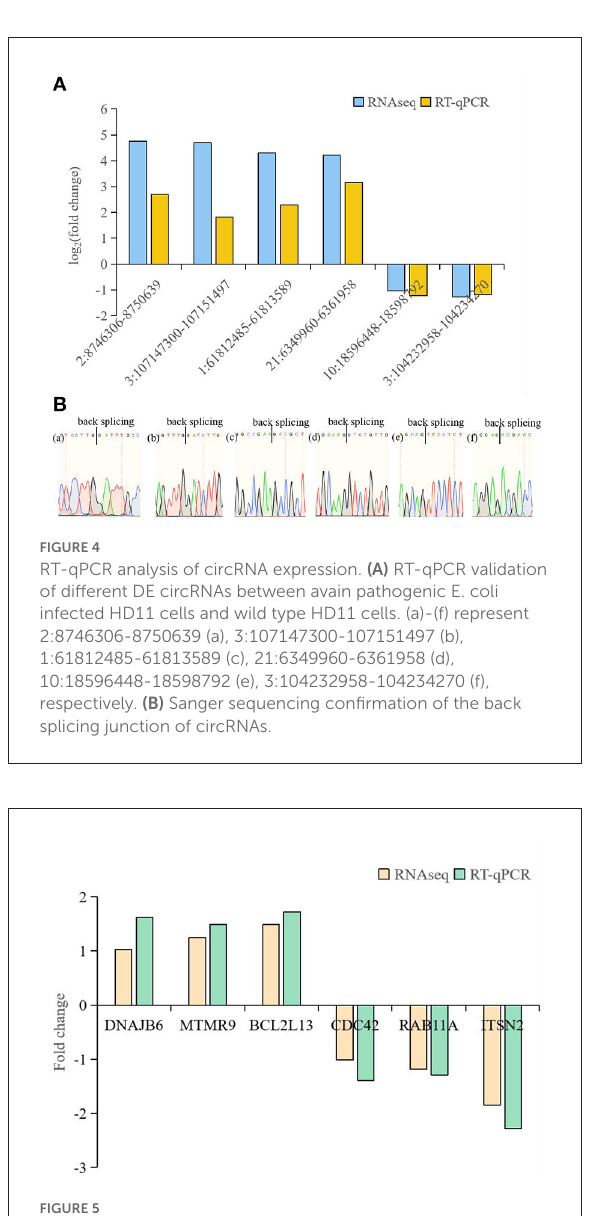
FIGURE5 RT-qPCR analysis of mRNA expression.